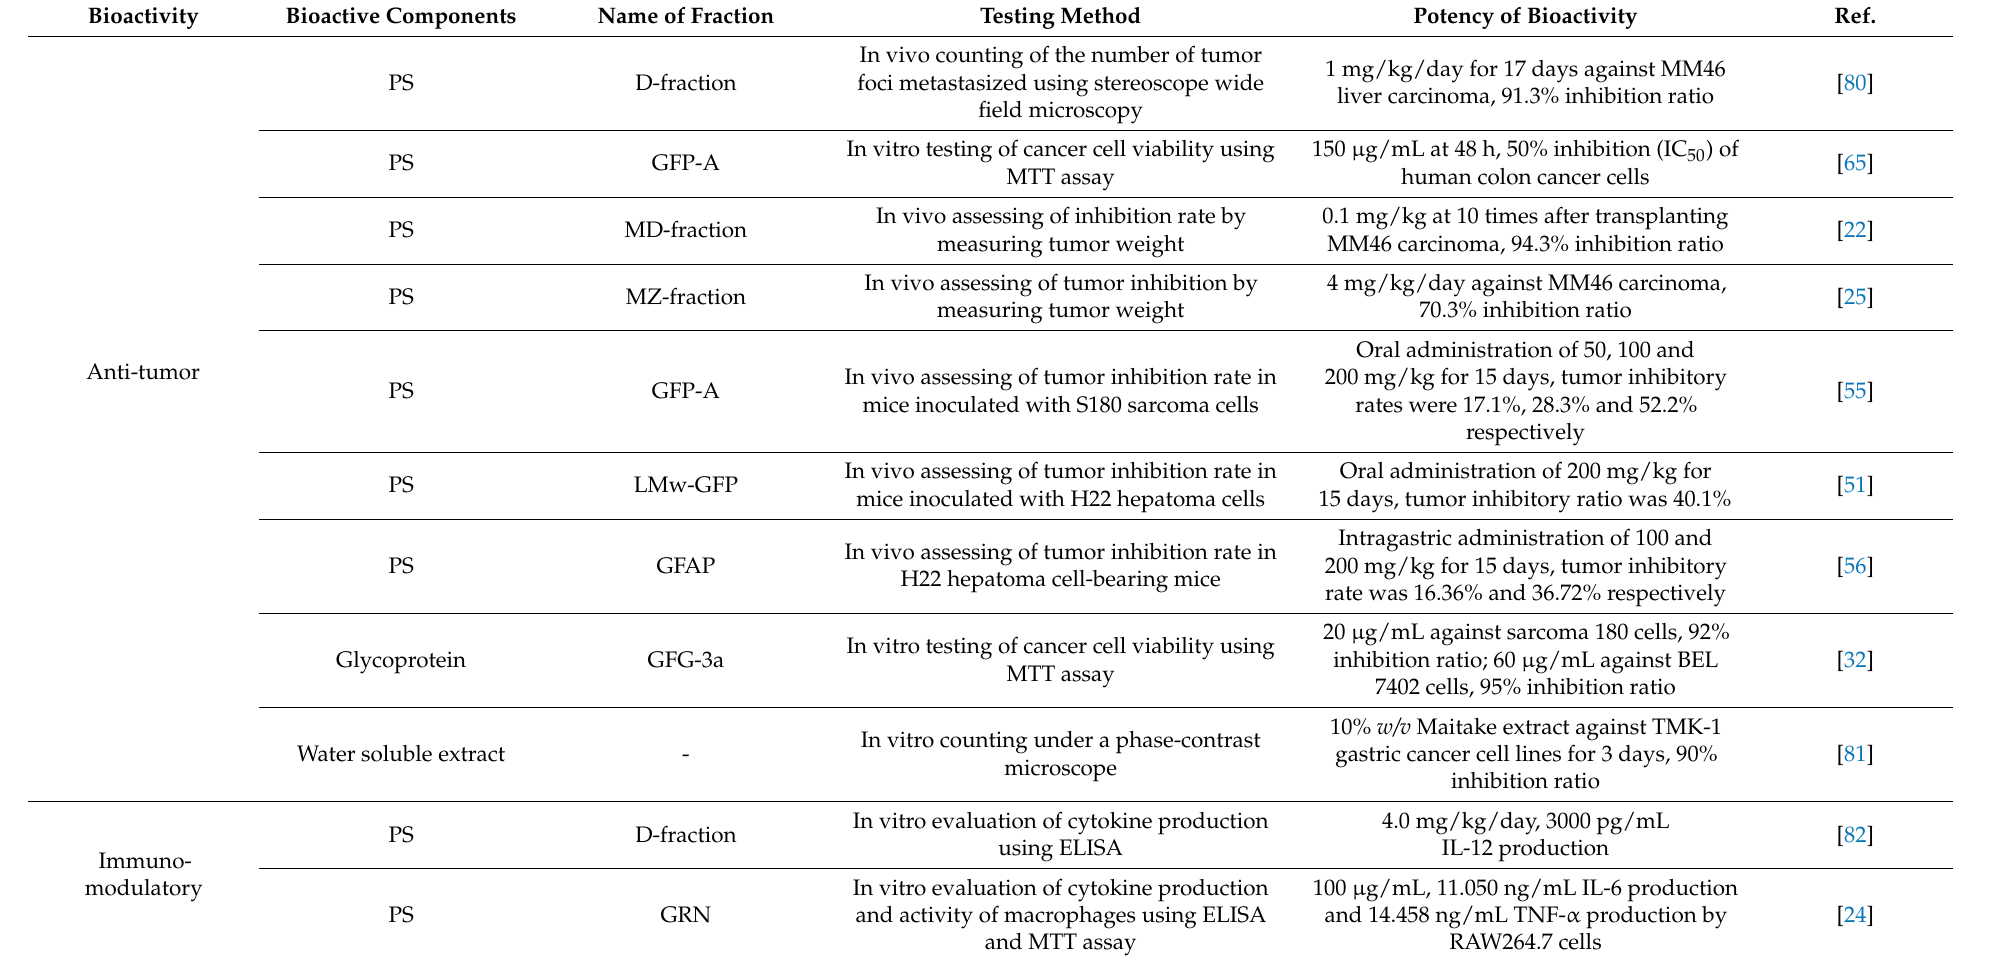
Table 7. Bioactivity potency and testing methods of major bioactive molecules isolated from G. frondosa